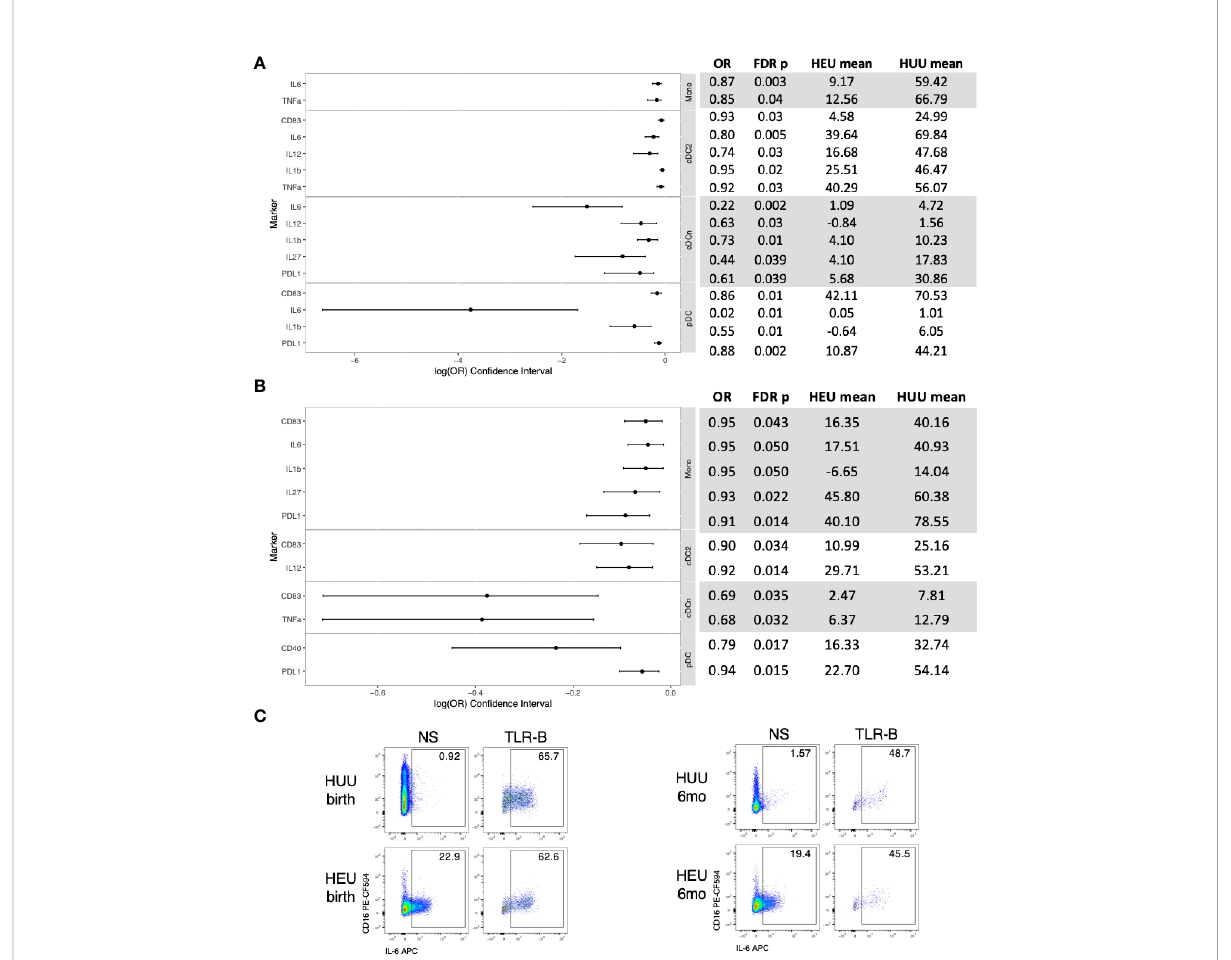
FIGURE 2 Differential functional characteristics of APC in HEU and HUU at birth and 6 months of life. Data were derived from 24 HEU at birth, 28 HEU at 6 months, 64 HUU at birth and 45 HUU at 6 months. (A) Forest plot and summary statistics of signi fi cant differences in HEU and HUU at birth. Means indicate proportion of cells expressing the marker of interest in TLR-stimulated conditions (TLR-B) after subtraction of the proportion of cells in unstimulated conditions (NS). (B) Forest plot and summary statistics of signi fi cant phenotypic differences in HEU and HUU at 6 months of life. (C) Representative scatter plots of IL6+ Mono (Lin-HLADR+CD14+) illustrating differences between HEU and HUU at birth and 6 months of